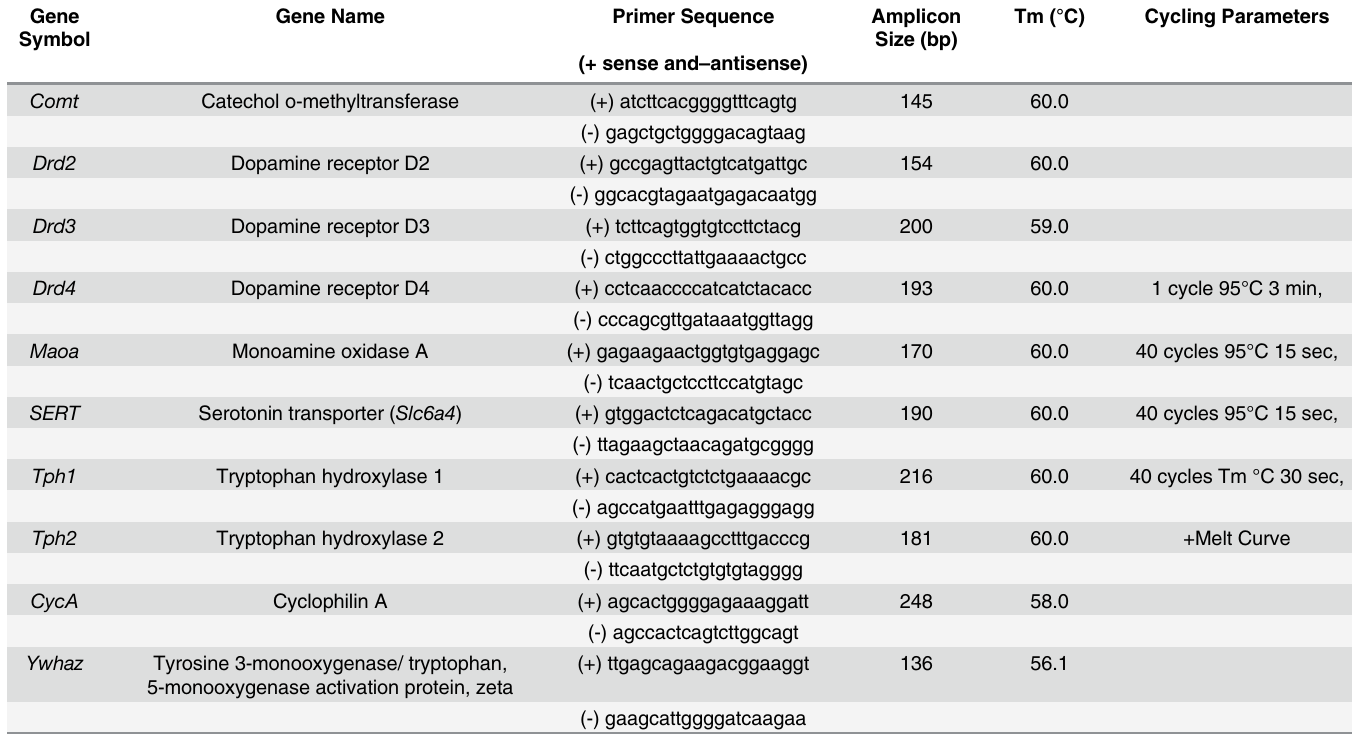
Table 1. Primer information for the 8 genes examined with relative